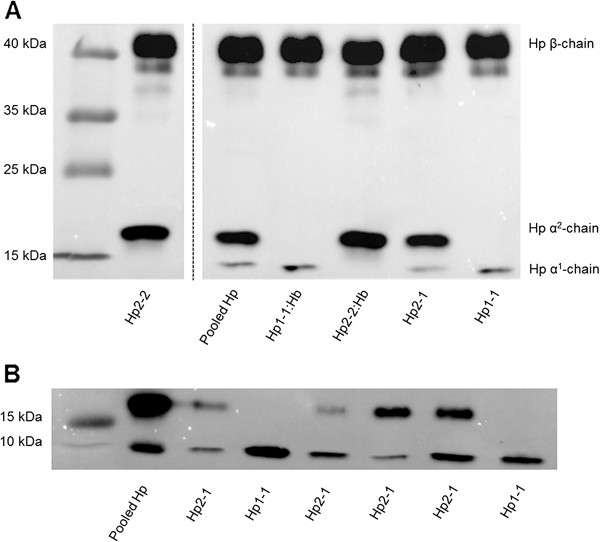
Determination of haptoglobin phenotypes by Western Blot. In total 159 plasma samples were analysed for haptoglobin phenotype. Figure A shows a membrane with bands correcponding to the alpha-subunits (8.9 kDa/16 kDa) and the betha-subunit (40 kDa) of the haptoglobin protein. The membrane shows bands for the pooled human haptoglobin, the two Hp:Hb complexes (Hp1-1:Hb and Hp2-2:Hb) and plasma samples from the cohort corresponding to the Hp1-1, Hp2-1 and the Hp2-2 phenotype in similar band patterns. One lane was cut out from the gel due to individual variation in the haptoglobin concentrations. Figure B, shows a representative membrane of the α-subunits of the haptoglobin protein in different plasma samples as well as the pooled human haptoglobin protein that was included as a positive control on each membrane.